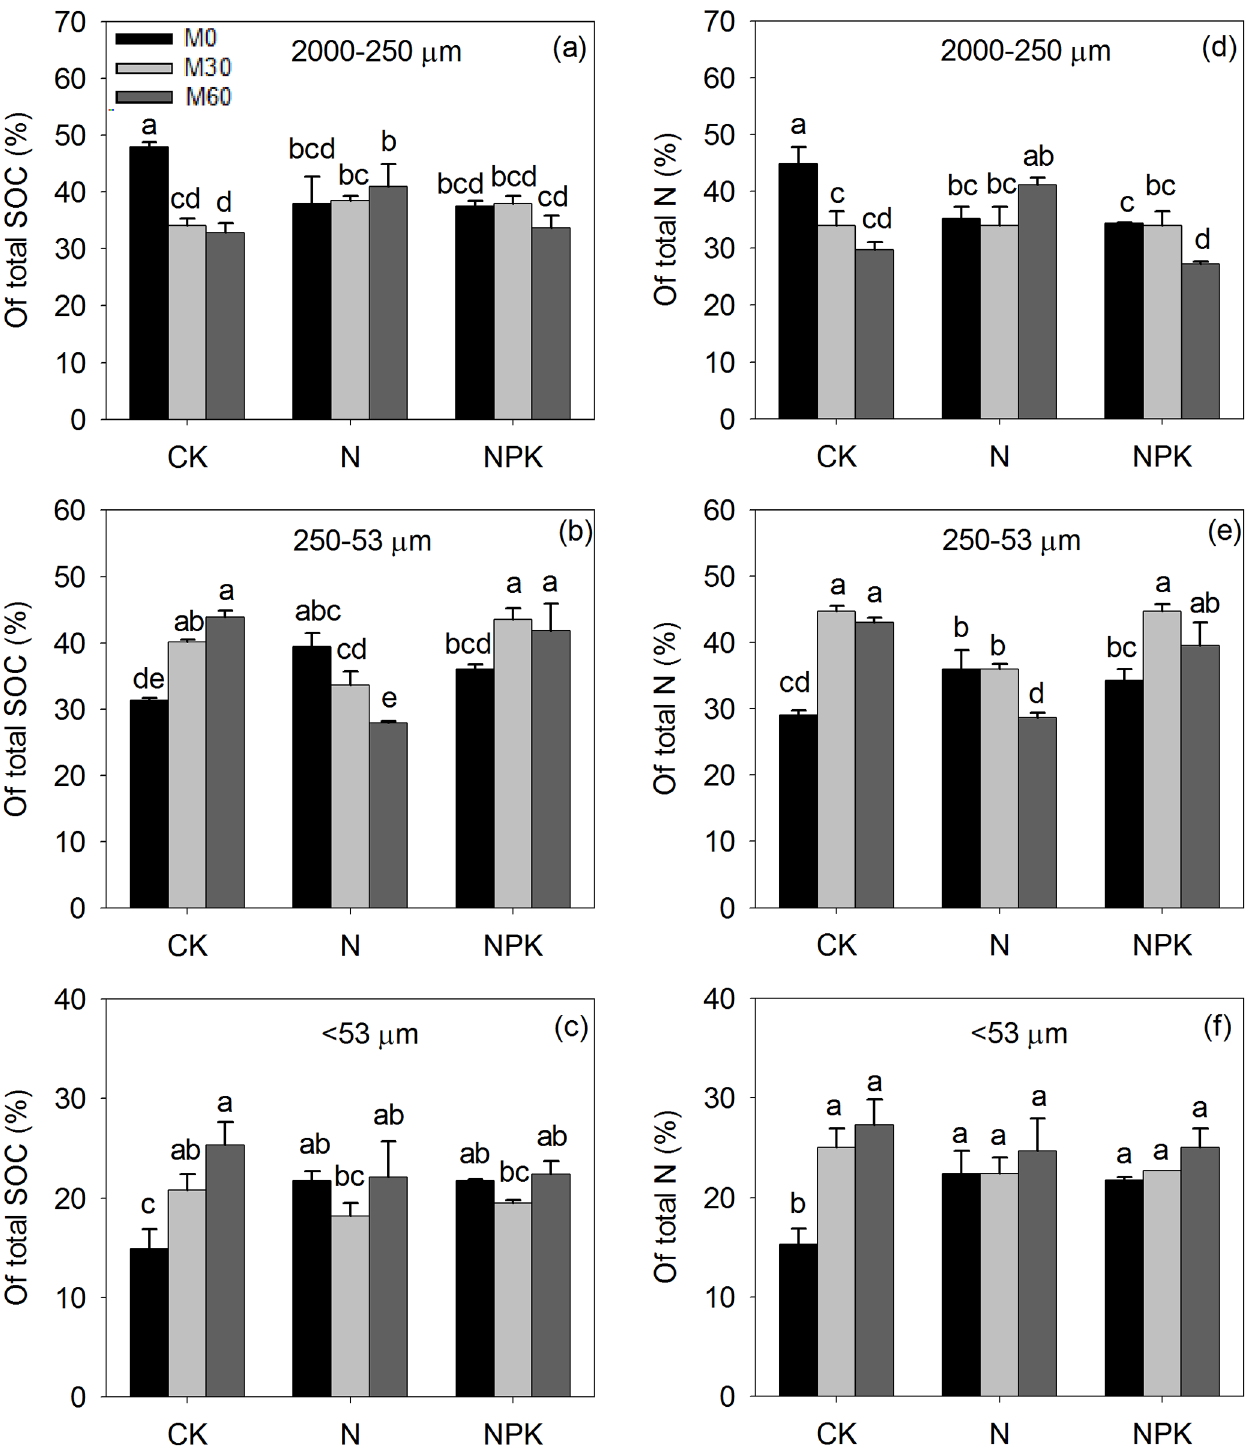
Fig 3. The percent (%) of soil organic carbon (SOC) in 2000 – 250 μ m (a), 250 – 53 μ m (c), < 53 μ m (e) fraction and total nitrogen (N) in 2000 – 250 μ m (b), 250 – 53 μ m (d), < 53 μ m (f) fraction from the control (CK) or soil that received 32 years of chemical fertilizer application (N, P: phosphorus, K: potassium) and either 0 (M 0 ), 30 (M 30 ) or 60 (M 60 ) t manure ha -1 yr -1 . Note: Different letters above the bars indicate significant differences at 5% probability level. Capped bars are standard error of the mean (n = 3).